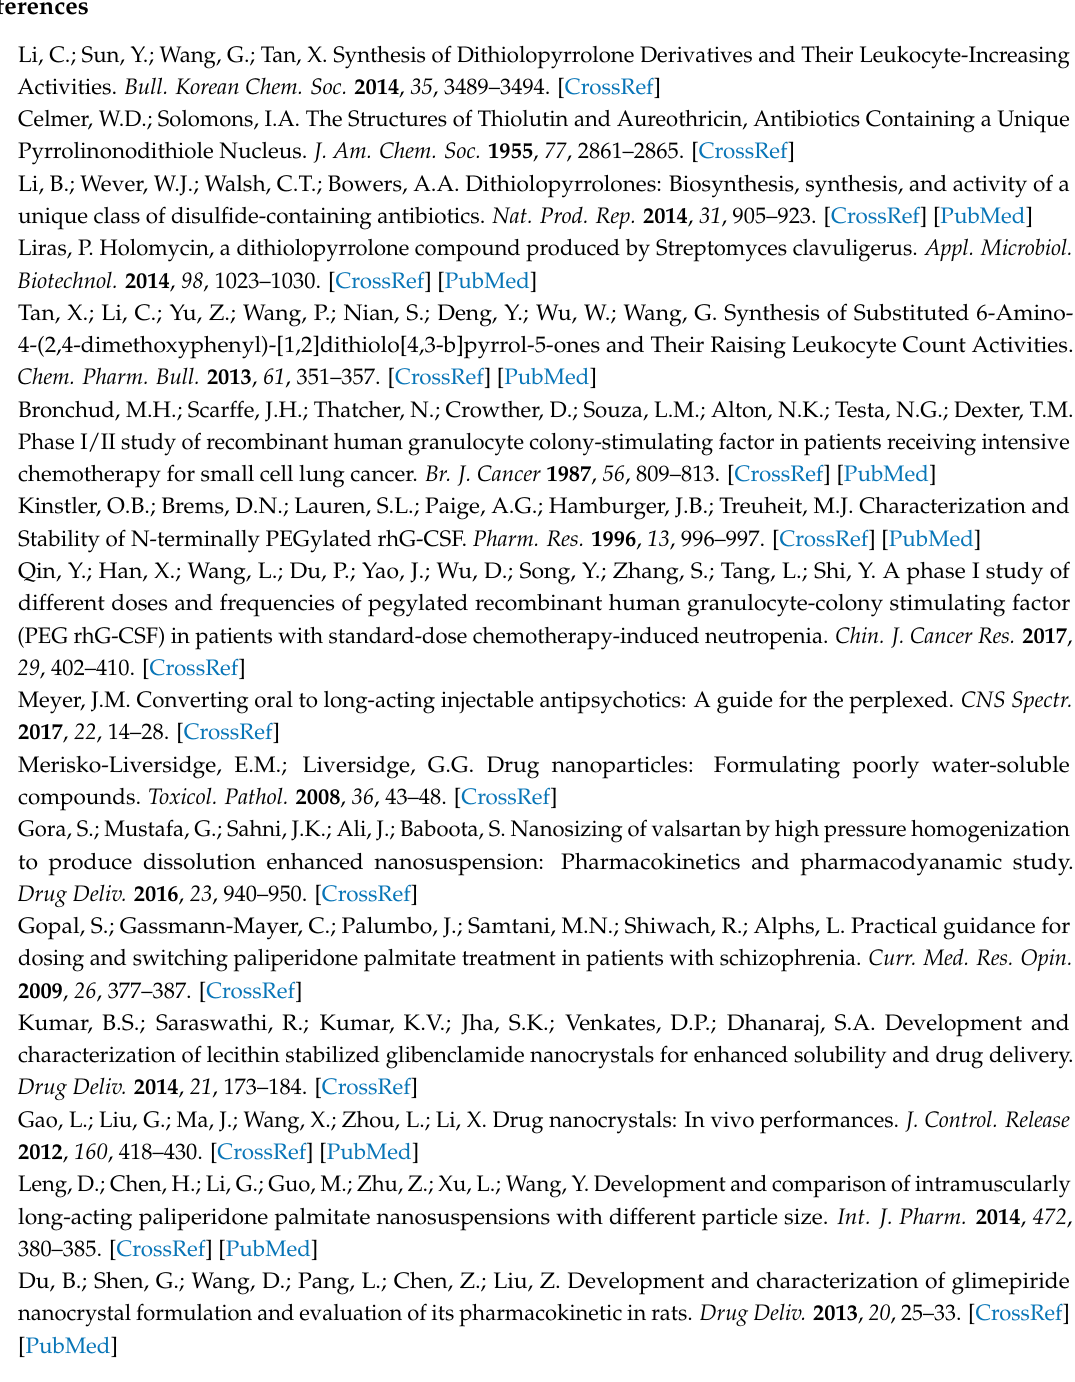
Supplementary Materials: The following are available online. Figure S1: Effect of homogenization time, pressure, and concentration of Tween-80 on the particle size, Figure S2: DSC curves of NS-PA, NS-PB, NS-PC, NS-H α , and API (a). XPRD curves of NS-PC, NS-H α , and API (b), Table S1: The particle sizes of NS-H α -1 and NS-H α -2 during storage of 3 months at room temperature (Mean ± SD, n =